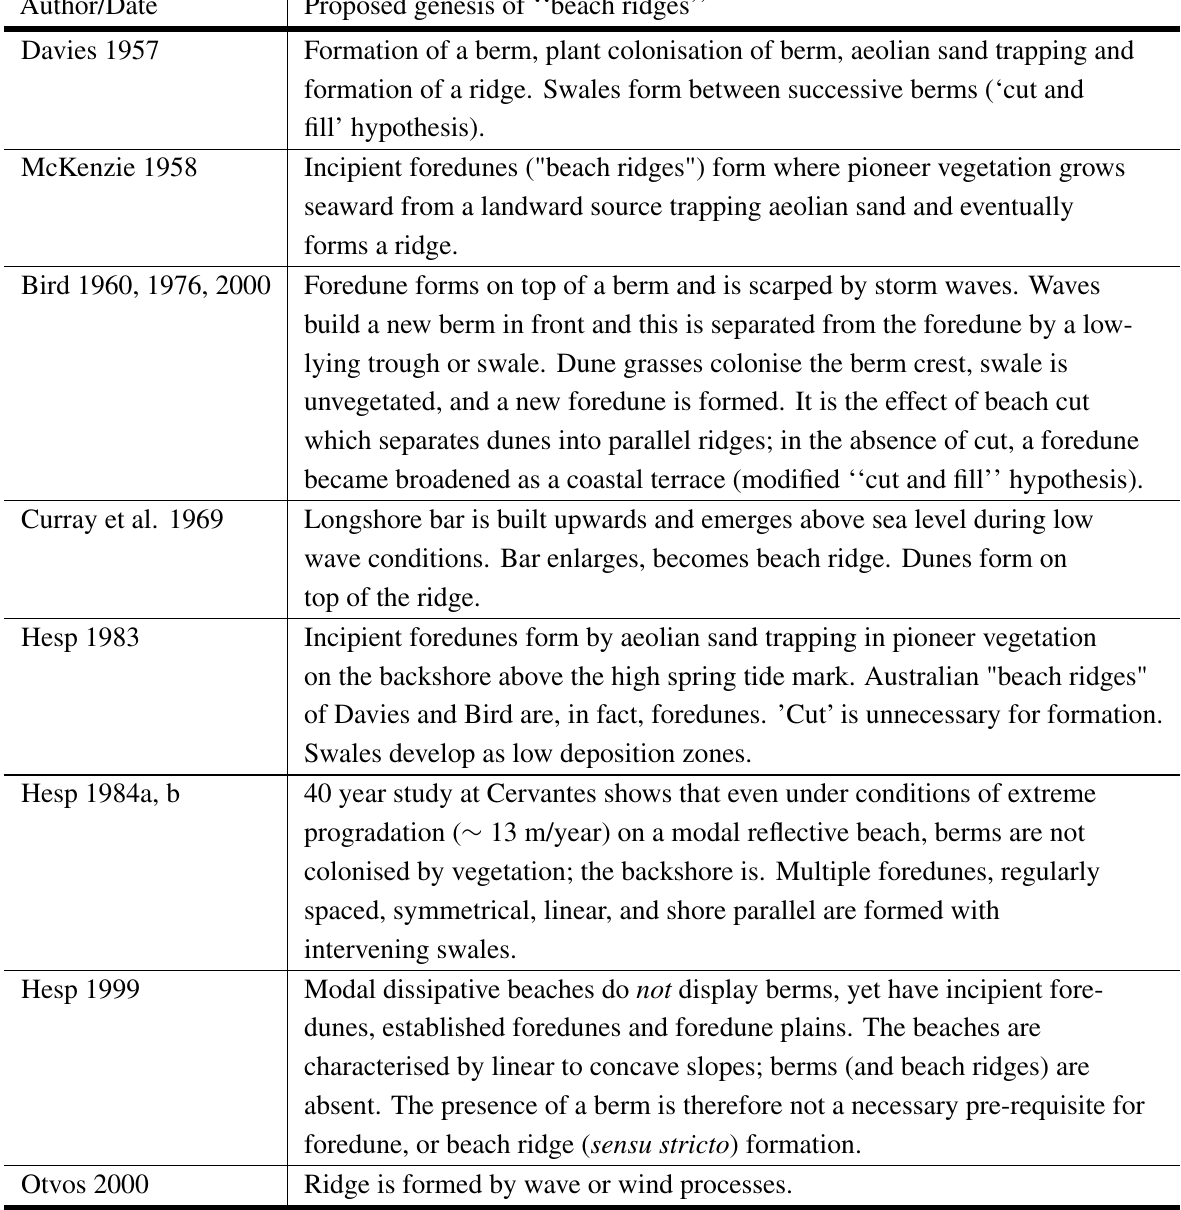
Some of the hypotheses and data for the initiation of sand ‘‘beach ridges’’ (so-called) and foredunes (apart from Otvos, and excluding wave-formed beach ridges). It may be seen that most sand ‘‘beach ridges’’ in this list are, in fact, foredunes formed by aeolian sand deposition in vegetation on the